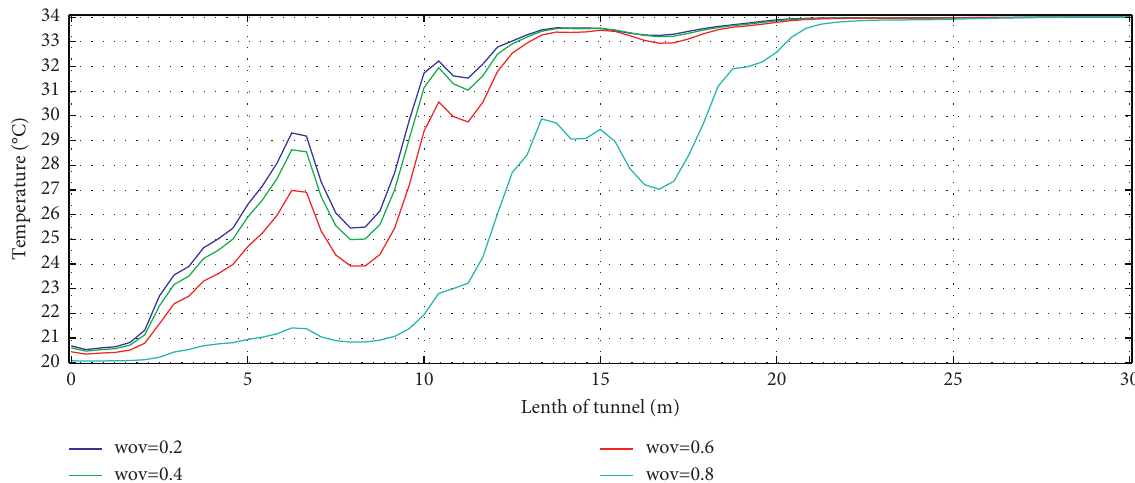
Figure 10: Temperature distribution of wall surface under different humidity.